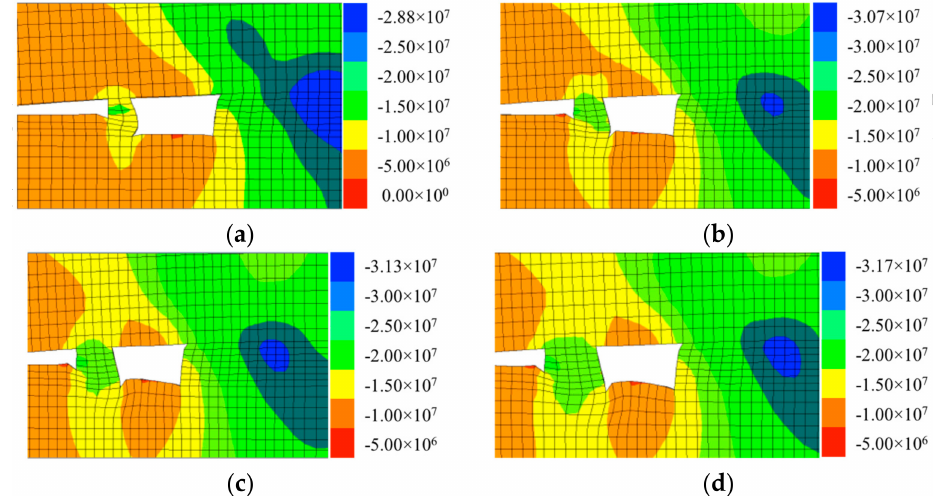
Figure 10. Vertical stress distribution with respect to RBB width (units: Pa): ( a ) RBB of 0.8 m wide; ( b ) RBB of 1.2 m wide; ( c ) RBB of 1.6 m wide; and ( d ) RBB of 2.0 m